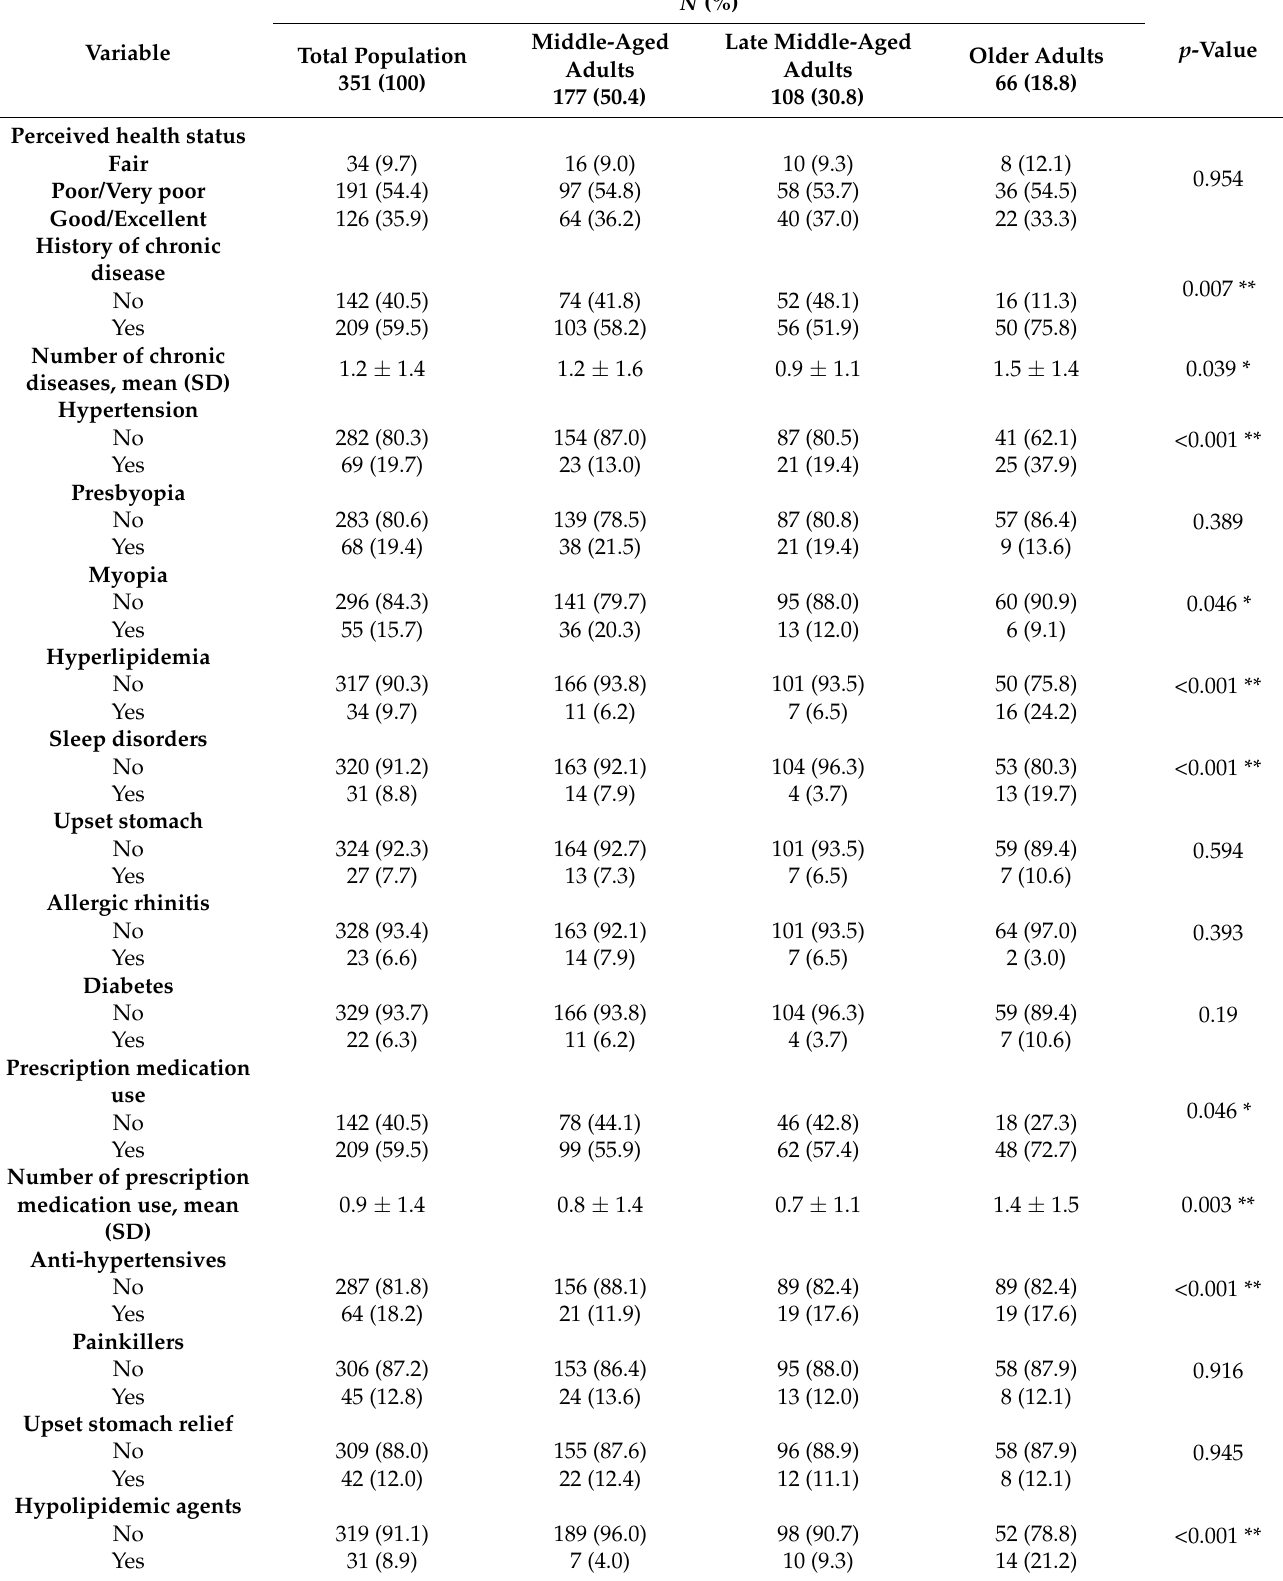
Table 2. Health conditions and medication use in study participants ( N =